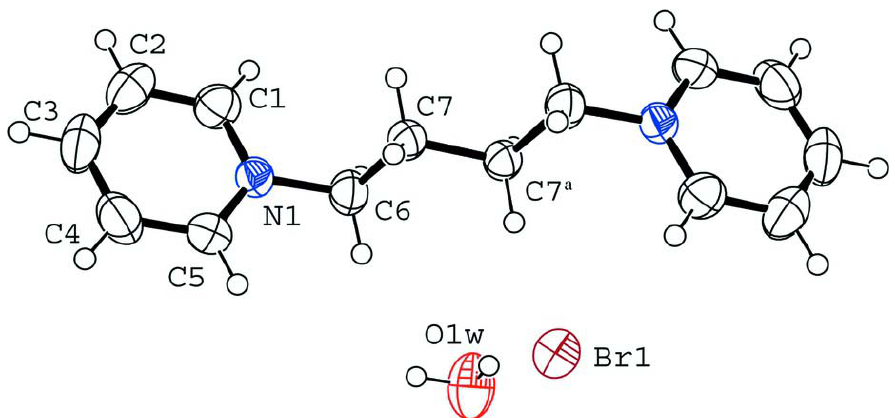
Figure 1 The molecular structure of (I) showing the atom-labelling scheme. Displacement ellipsoids are drawn at the 50% probability level. Symmetry code of C7 a : - x + 1, - y , - z + 1. 1,1 ′ -(Butane-1,4-diyl)dipyridinium dibromide